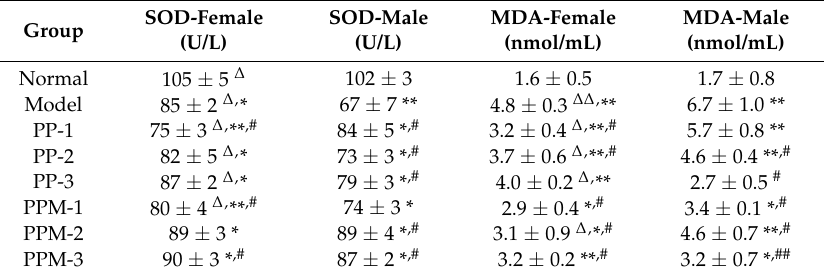
Table 3. SOD activity and MDA levels in serum of different groups of mice.